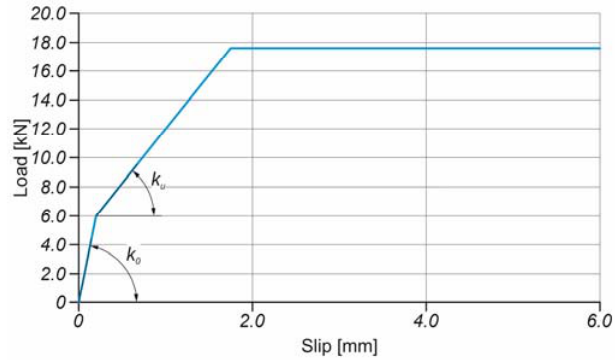
Figure 4. The load–slip response adopted for the discrete connection. Additionally, steel elements representing the screws were embedded in the LVL slabs to consider the presence of the screws in the slabs. The loading and supporting steel plates, the aluminium girders, and the LVL slabs were modelled using 4 ‐ node bilinear plane stress quadrilateral elements with reduced integration and hourglass control (CPS4R). The screws were modelled using T2D2 linear line elements. The mesh size did not exceed 5 mm. The interaction between beam parts was captured by surface ‐ to ‐ surface “hard” contacts and friction contacts. In the case of the LVL–aluminium interface, the friction coefficient equal to 0.3 was adopted, just like for the LVL–steel frictional interac ‐ tion [52,69]. In the case of the steel–aluminium interface, a friction coefficient equal to 0.3 was used. Figure 5 presents the boundary conditions used in the numerical analyses.